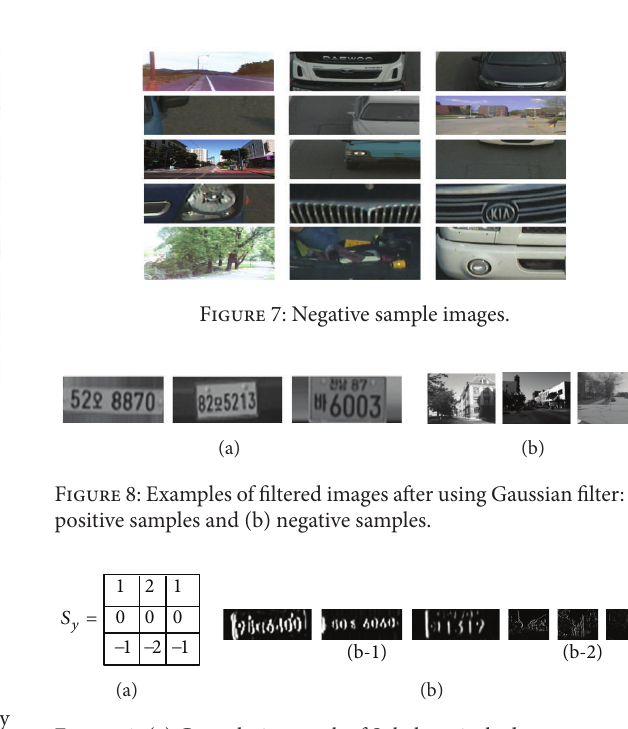
Figure 9: (a) Convolution mask of Sobel vertical edge operator, (b) examples of edge images after using Sobel vertical edge operator (b- 1) positive samples and (b-2) negative samples.